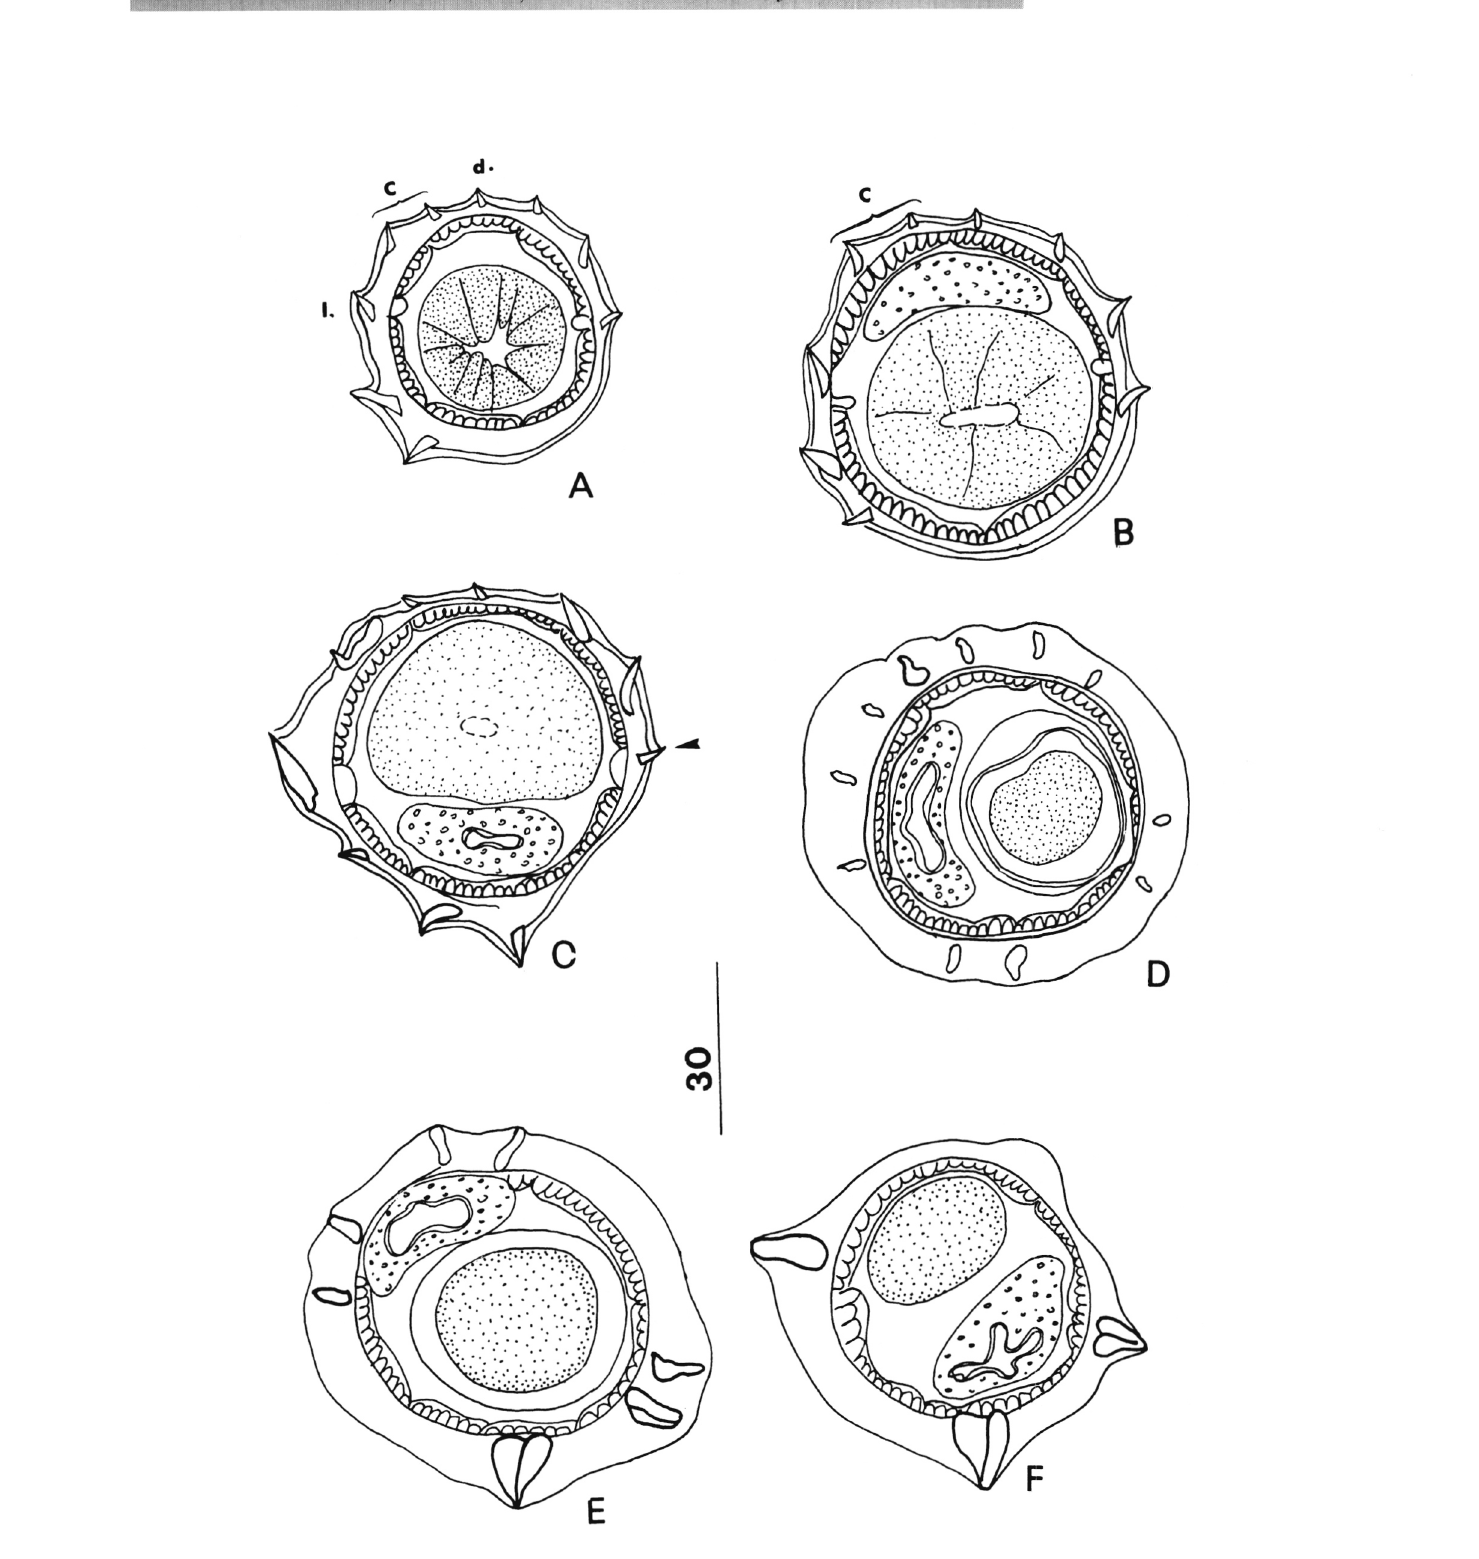
Fig. 2. - Pudica ginsburgi n. sp. paratype female, 3.1 mm long, transverse sections of the body. A, section between the level of the excre­ tory pore and the end of the oesophagus. B, at 300 μm from the oesophago-intestinal junction. C, at mid-body. D, at level of the infun- dibulum. E, at level of the spincter. F, at level of the vestibule. All the sections are orientated as A. Abbreviations: c: carene, 1: left side, d: dorsal side. Arrow: arising of a new ridge.